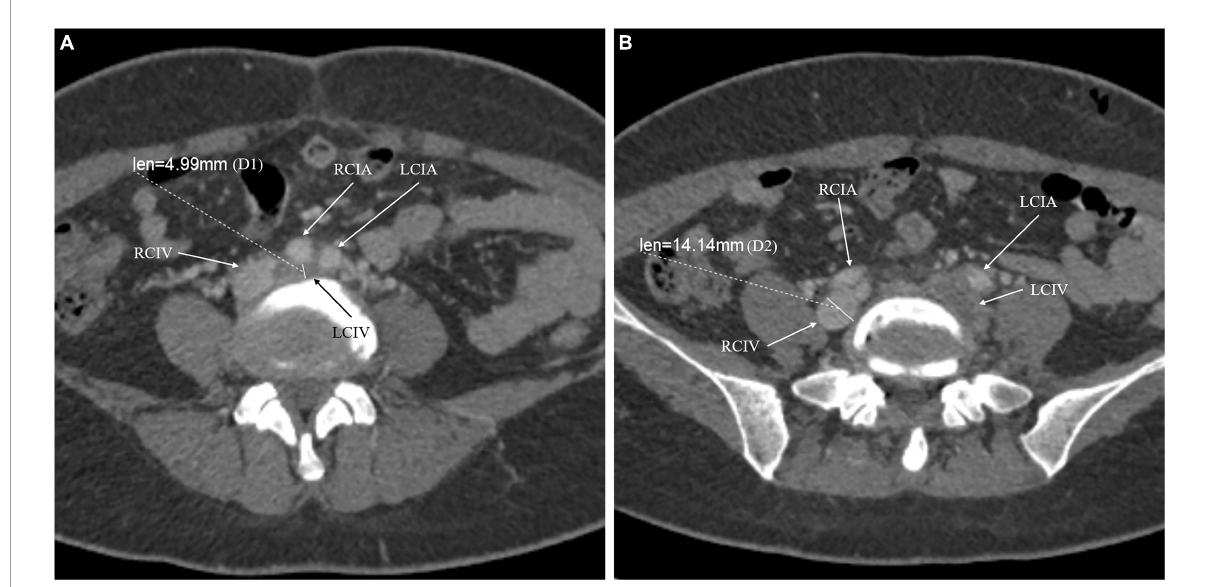
FIGURE1 The compression percentage of the common iliac vein was calculated using the following formula: (1 – D1 / D2) × 100%. D1 is the minimum diameter at the point of maximum compression (A) . Because the left common iliac vein was involved, D2 is the minimum diameter at the right common iliac vein caudal to the compression (B) . For instance, the compression percentage of LCIV for the presented patient was: (1 – 4.99 / 14.14) × 100% = 64.7%. RCIV, right common iliac vein; RCIA, right common iliac artery; LCIV, left common iliac vein; LCIA, left common iliac